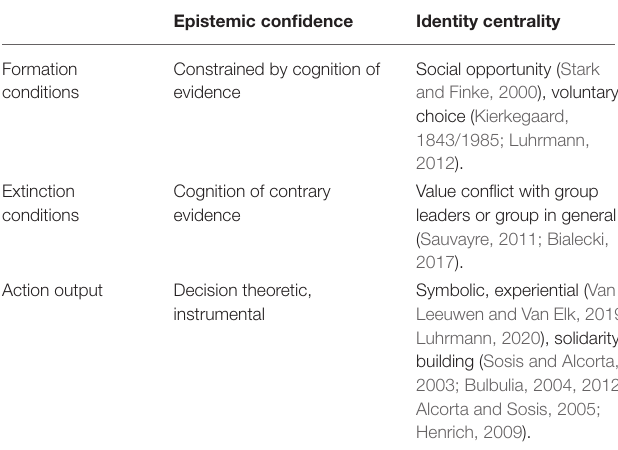
TABLE 1 | Dimensions of difference: epistemic confidence and identity centrality. Epistemic